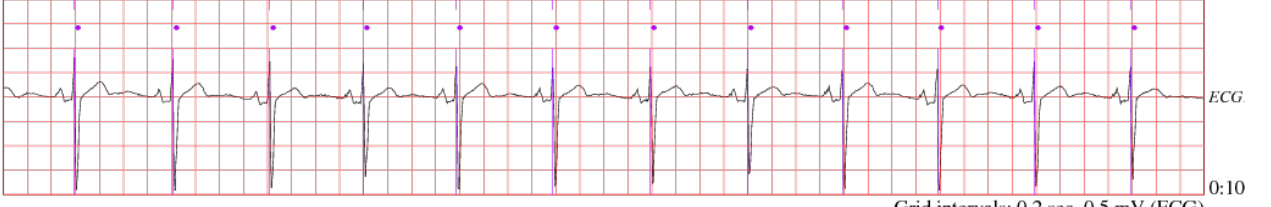
Figure 7. ECG waveform of 20-year-old female